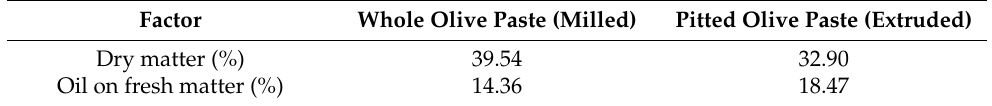
Table 3. Analyses of the average characteristics of whole and pitted olive paste.